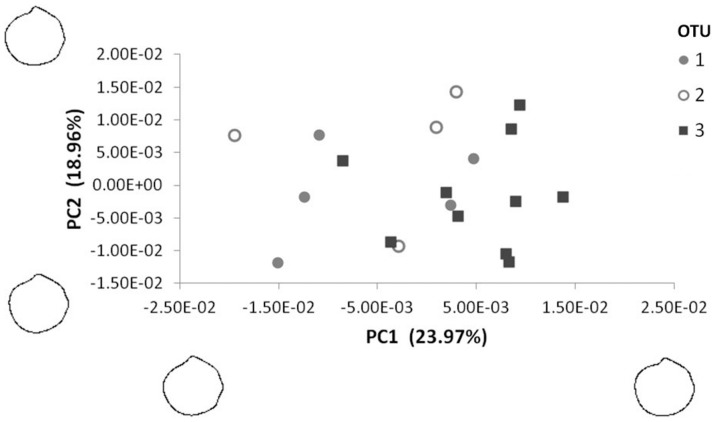
Shape variation in a subset of shells along the first two principal components.Shells analysed belong to group B in Figure 3. Reconstructed contours show shapes at the extremities of each axis. Symbols refer to operational taxonomic groups (OTUs) based on CO1, 18S and 28S rRNA sequences.